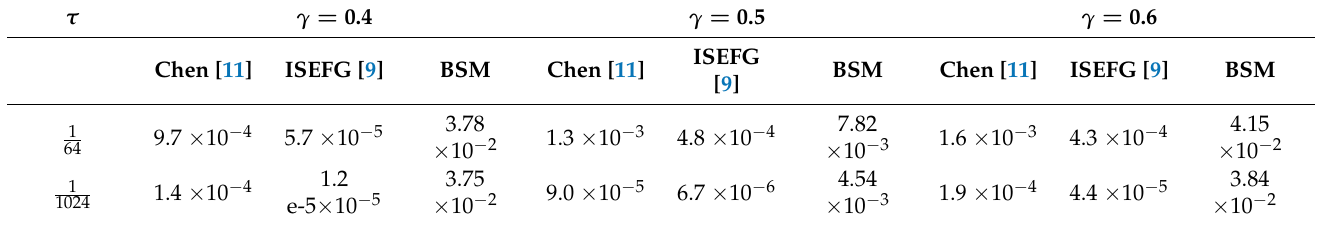
Table 4. E max and the effect of the time steps at times T = 1 for Example 4, where c = 10, α = 2, ν = 1, K = 180, M = 52, and N = 12.